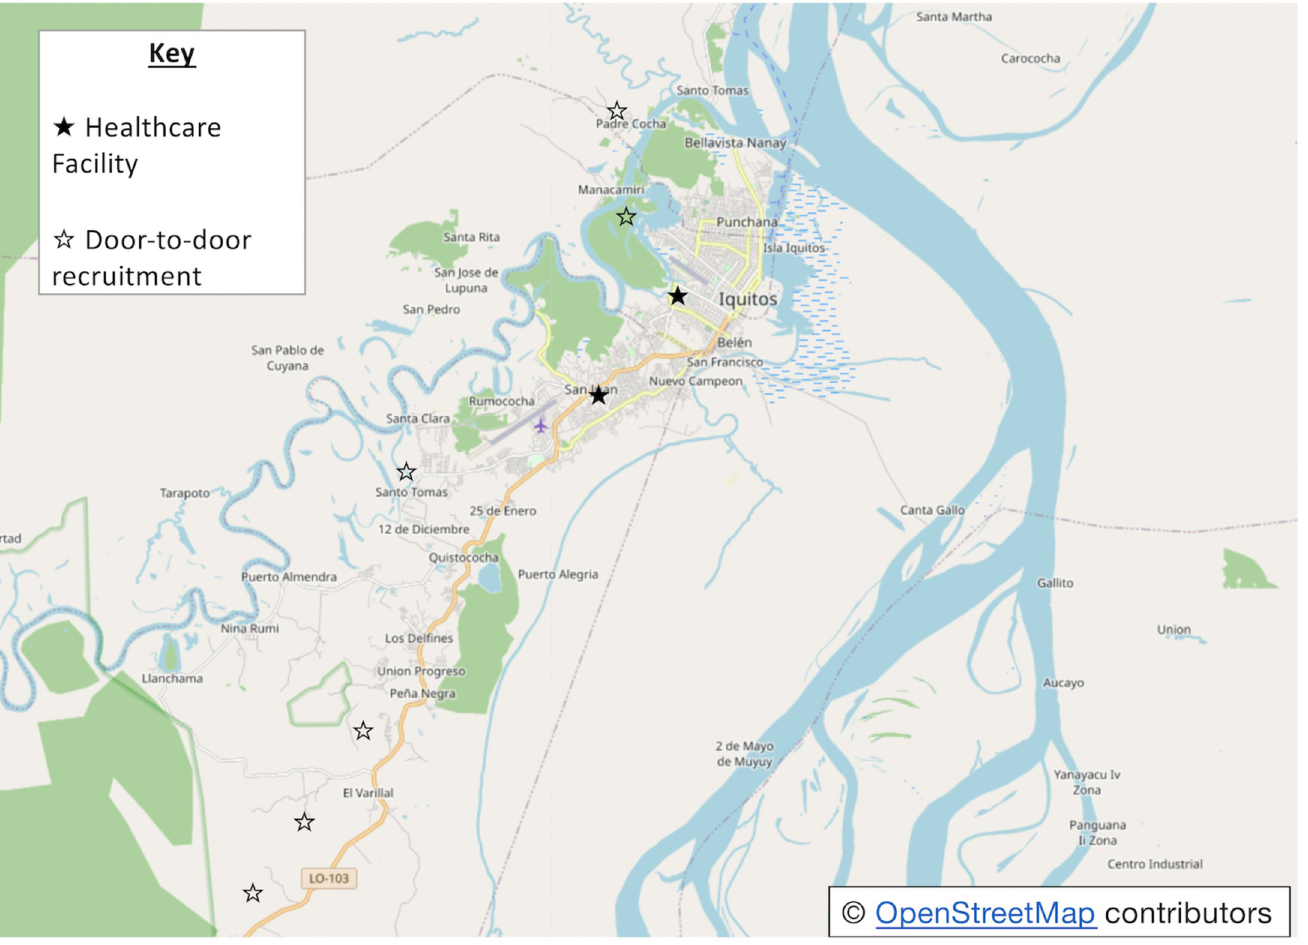
Fig 2. Map of recruitment sites including primary healthcare facilities and neighbourhoods. Adaptation of image from Google Maps [48].